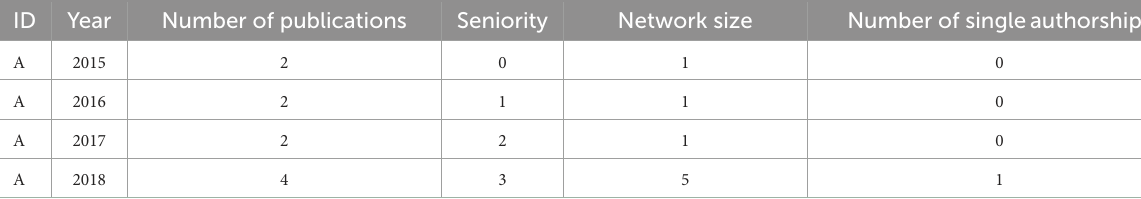
TABLE 1 Representation of selected variables using all records of a fictitious author A as an example.